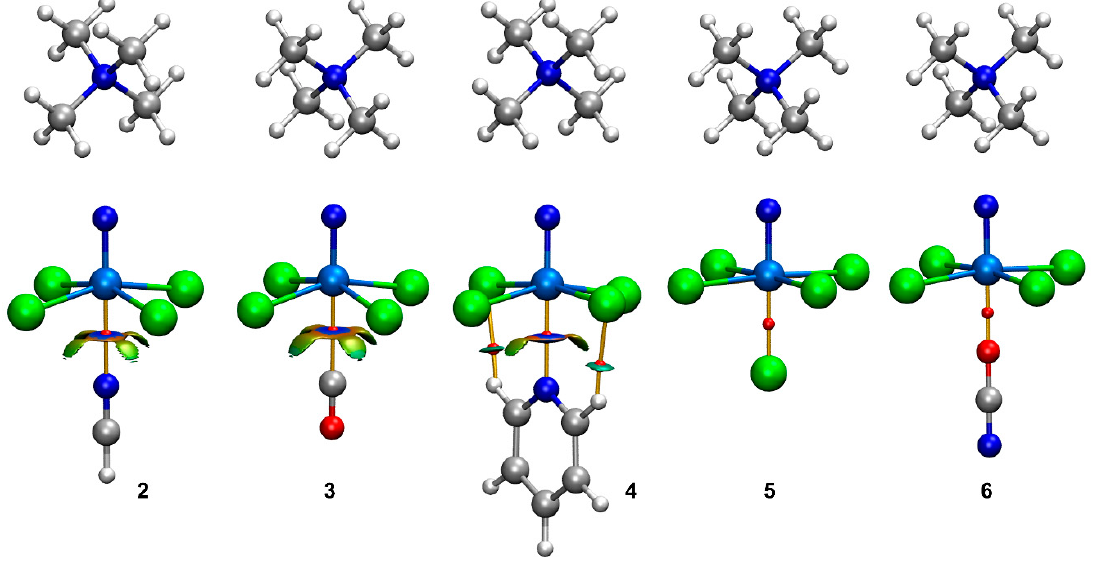
Figure 3. QTAIM/NCIPlot analyses of the OmB complexes 2–6 at the PBE0-D3/def2-TZVP. Only intermolecular contacts between the anionic unit and the electron donors are represented by bond CPs and RDG isosurfaces. See computational methods for the NCIplot settings.